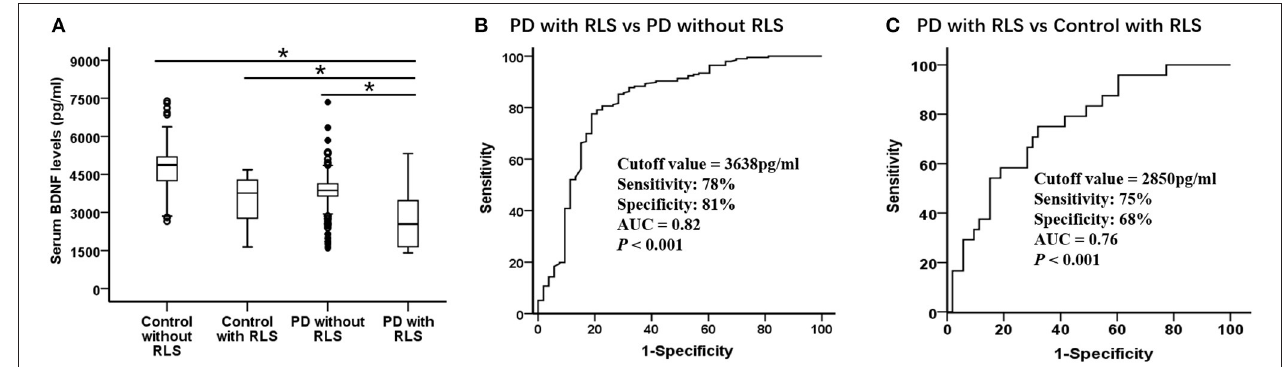
FIGURE 1 | Serum BDNF highly discriminates PD with RLS from without RLS and controls. Serum BDNF concentration in control with RLS and without RLS, PD with RLS and without RLS and diagnostic accuracy. (A) Mean serum BDNF level was significantly decreased in PD with RLS compared with without RLS and control with RLS and without RLS. Mean levels were shown with SD; * p < 0.001. (B,C) Receiver operating characteristic curve analyses for differentiating between (B) PD patients with RLS and without RLS and (C) PD patients with RLS and control with RLS. AUC, area under the curve; BDNF, brain-derived neurotrophic factor; PD, Parkinson’s disease; RLS, restless legs syndrome.